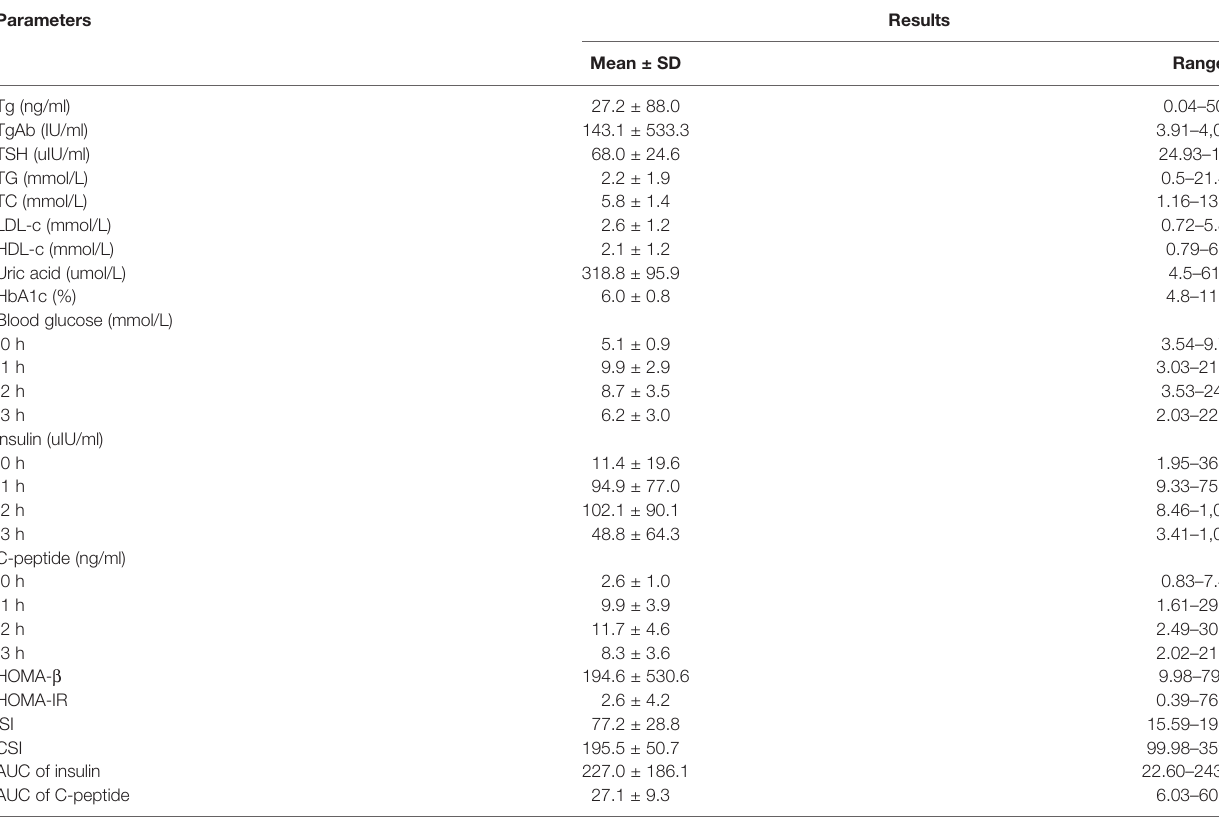
TABLE 3 | Glucose metabolism and related parameters of enrolled